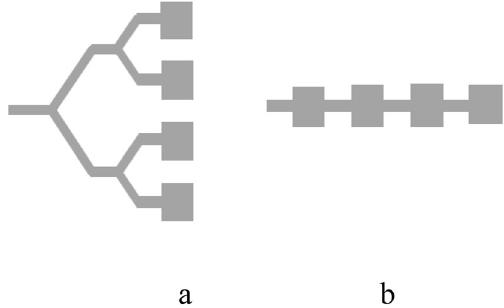
Figure 1. ( a ) Corporate and ( b ) series feed array structure 17 .